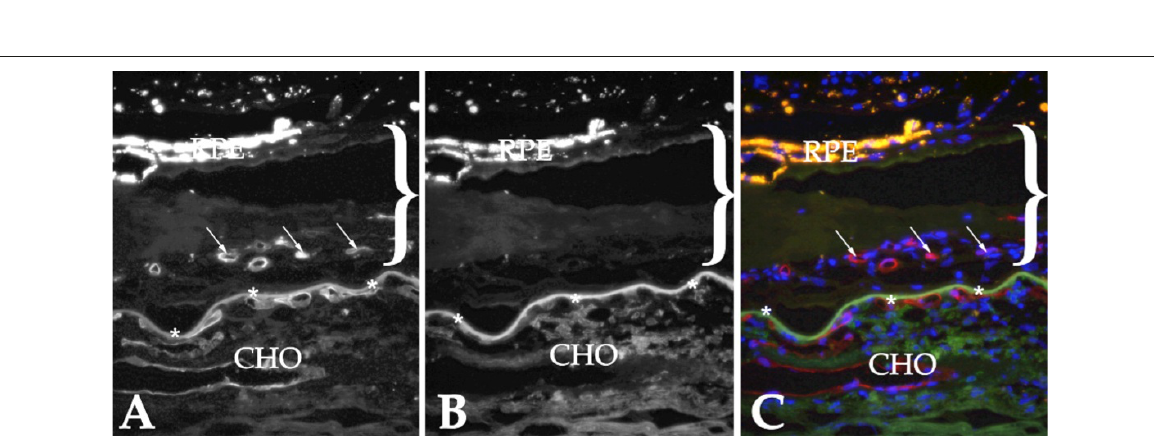
Figure 3 Evaluation of a human choroidal neovascular membrane with anti-P-selectin antibody . Sections of affected eyes were dual labeled with UEA-1 lectin, which binds both normal and neovascular endothelial cells (A), and antibodies directed against P-selectin (B). Panel C shows the merged image with DAPI (blue; UEA-I labeling appears red and anti-P-selectin labeling appears green). Labeling of the vasculature with P-selectin antibody was unremarkable. The extent of the neovascular membrane is indicated by the bracket. Arrows indicate endothelial cells within the neovascular complex and asterisks indicate points along Bruch ’ s membrane. RPE, two layer of dystrophic RPE cells above the neovascular membrane; CHO,